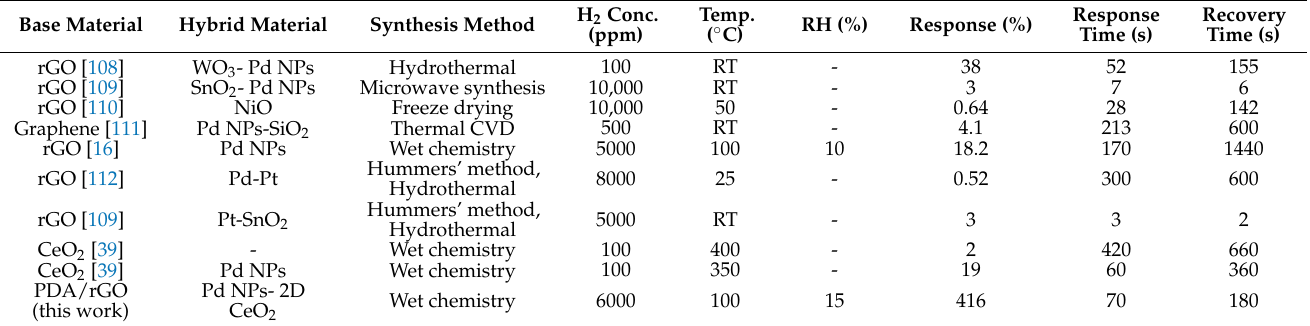
Table 5. Summarising H 2 sensing parameters of different graphene-based materials functionalised by noble metals and/or metal oxides and a pure CeO 2 compared with this